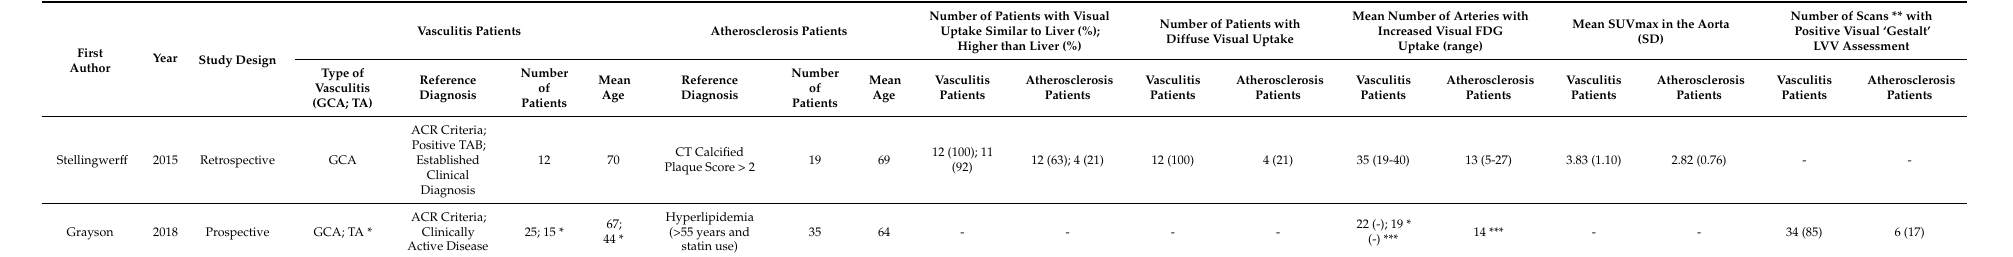
Table 3. Overview Outcome Parameters FDG-PET studies.